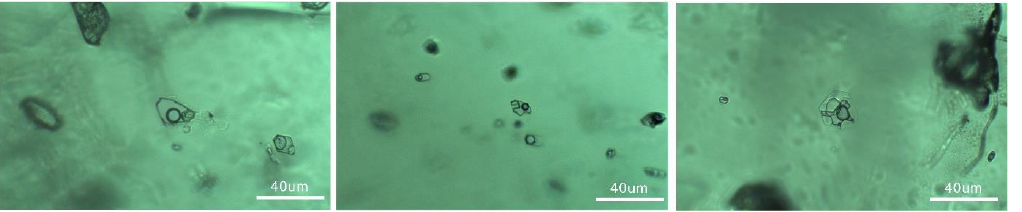
Figure 7. Three- and multi-phase inclusions showed a hexagonal outline in Indian emeralds. The inclusion components of the Indian emeralds were identified by Raman